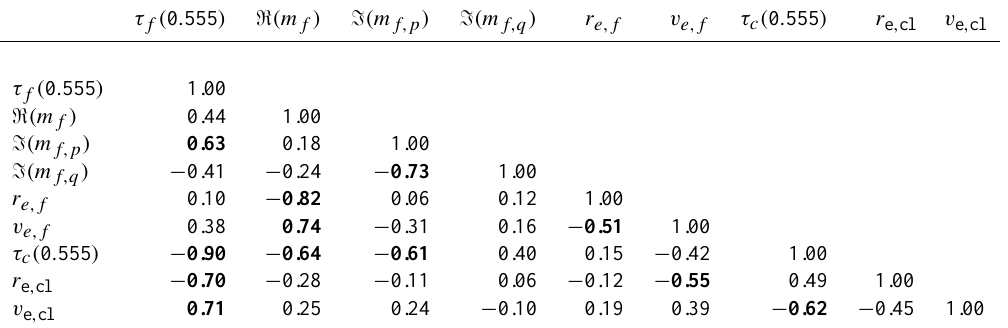
Table 6. Correlation matrix for a simulated AAC scene with ( τ f ( 0 . 555 ) = 0 . 1) and an optimization utilizing angles (20 ◦ ) and (60 ◦ ) forward of nadir. Elements with absolute values greater than 0.5, indicating strong correlation, are in